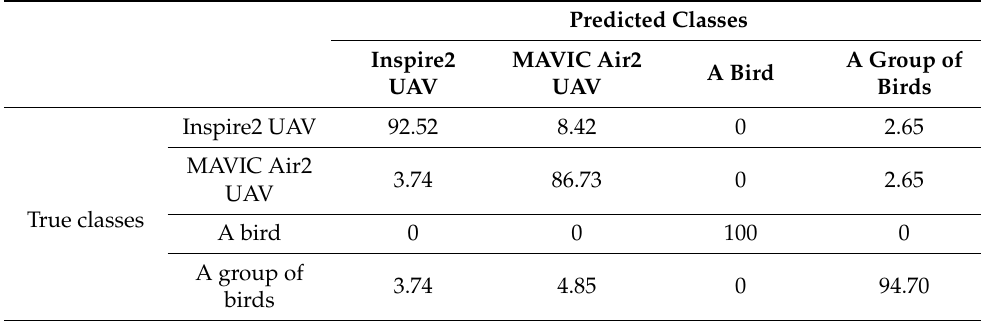
Table 6. Confusion matrix (%) of the